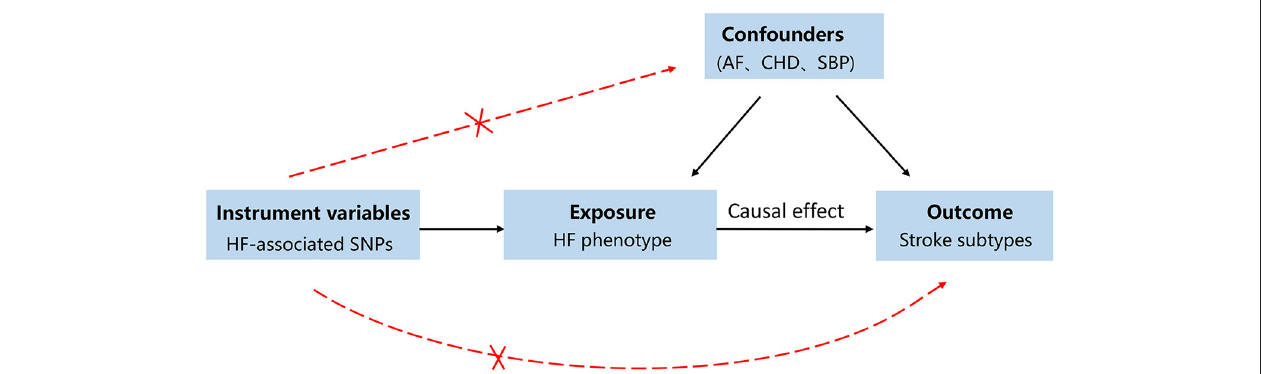
FIGURE 1 | A directed acyclic graph for the Mendelian randomization study design. We selected single nucleotide polymorphisms (SNPs) associated with heart failure (HF) as genetic instruments to estimate if the HF causally influences the stroke. To make causal inference for the effect of HF on stroke, we must additionally assume that the selected SNPs is not to be associated with confounders or the outcome. In order to address the bias caused by confounders, atrial fibrillation (AF), coronary heart disease (CHD), and systolic pressure (SBP) were included as confounding